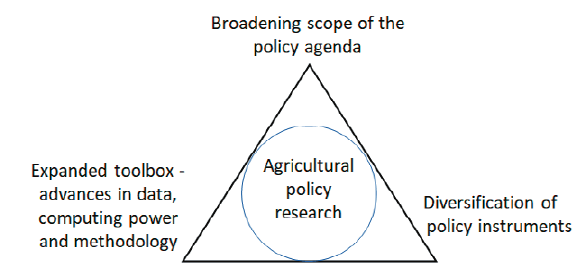
Figure 1. Major influences on European agricultural policy research. Source: Own